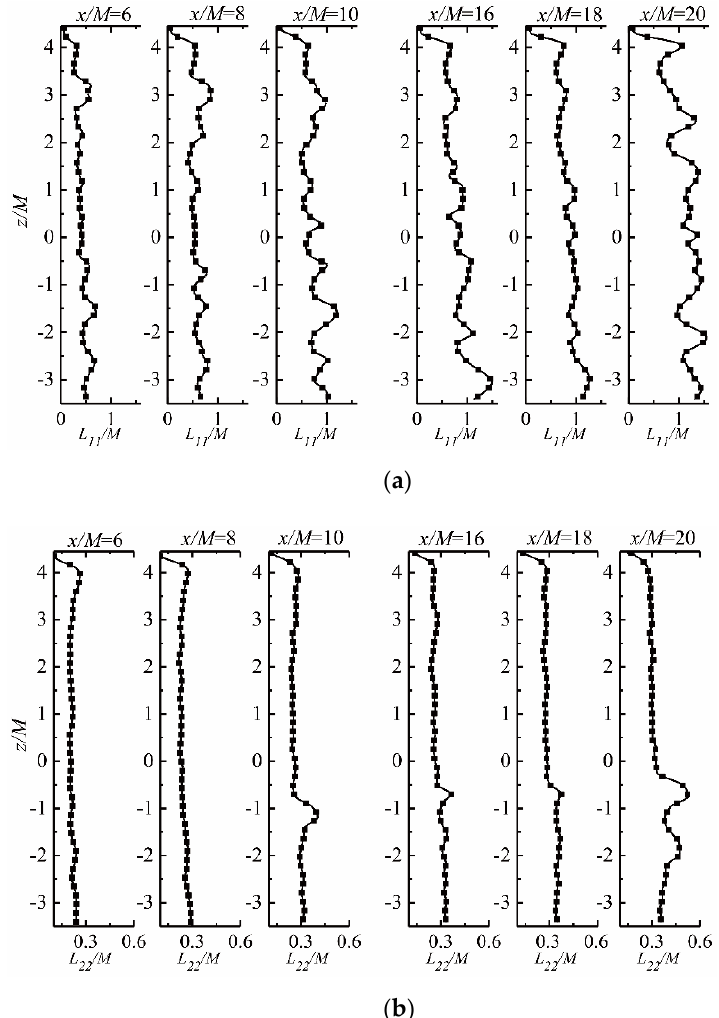
Figure 14. Vertical distribution of integral scales ( a ) longitudinal components ( L 11 / M ); ( b ) lateral components ( L 22 / M ) at mid-span of channel.